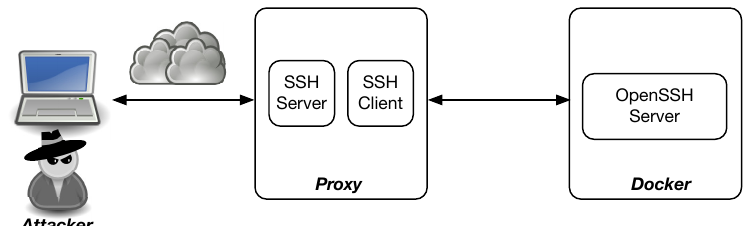
Figure 2. The architecture of proxy-based